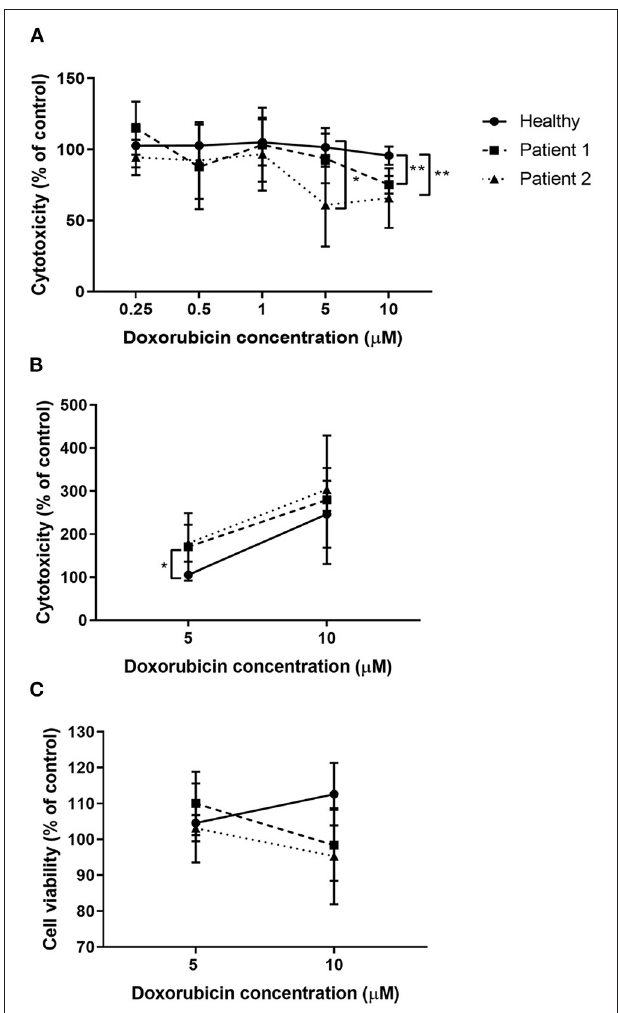
FIGURE 6 | Doxorubicin treatment reduced viability of nasal epithelial cells from patients with ABCA-3 deficiency. Submerged cultures of primary nasal epithelial cells from participants with and without ABCA-3 deficiency were exposed to 0, 0.25, 0.5, 1, 5, or 10 µ M of doxorubicin for 3h at 37 ◦ C. Cell viability or cytotoxicity was measured 24h post doxorubicin treatment. Viability, as measured using an MTS assay (A) , of nasal epithelial cells from Participant 2 was reduced by treatment with 5 µ M doxorubicin ( n = 3; p = 0.01) compared to healthy controls ( n = 7). Doxorubicin at 10 µ M significantly reduced viability of nasal epithelial cells from Participant 1 ( n = 3; p = 0.002) and Participant 2 ( n = 3; p = 0.006). To validate MTS assay results, submerged cultures of nasal epithelial cells from participants with and without ABCA-3 deficiency were exposed to 0, 5, or 10 µ M doxorubicin for 3h at 37 ◦ C. Doxorubicin at 5 µ M but not 10 µ M resulted in significantly increased cytotoxicity, measured using an LDH assay (B) , in nasal epithelial cells from Participant 2 ( n = 3; p = 0.02) compared to healthy control nasal epithelial cells ( n = 4) while doxorubicin treatment had no significant effect in nasal epithelial cells from Participant 1 ( n = 3). No detectable differences in cell viability were observed between cell cultures from participants with and without ABCA-3 deficiency using calcein blue staining (C) . Sample size reflects biological replicates (healthy control cell cultures) or separate repeated experiments (participant cell cultures). Experiments were performed in triplicate. Data were normalized to the untreated control and expressed as a percentage. * p < 0.05; ** p <